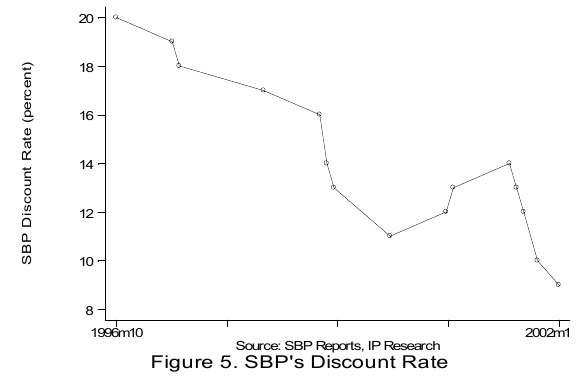
Research1996m10 Source: SBP Reports, IP Figure 5. SBP's Discount Rate